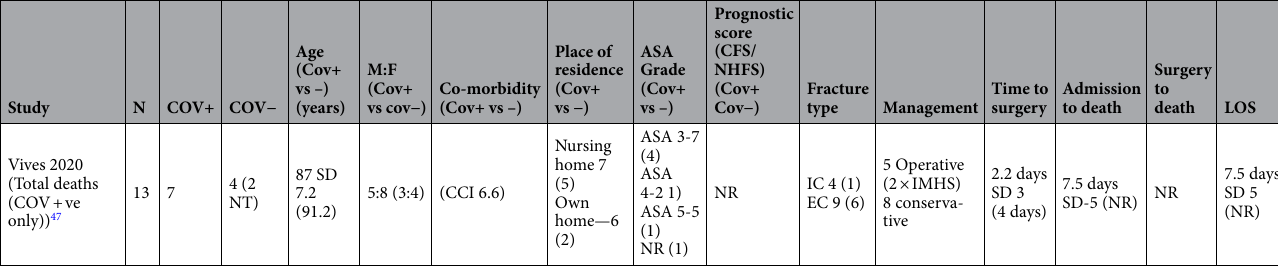
Table 3. Characteristics of deceased patients. N Number of patients, COV+ COVID-19 Positive patients, COV– non-COVID-19 patients, ASA American society of anaesthesiologists, LOS length of stay, NR Not reported, SD Standard deviation, CFS Clinical frailty score, NHFS Nottingham hip fracture score, IMHS Intramedullary Hip screw, HHA Hip hemiarthroplasty, DHS Dynamic hip screw, THA Total hip arthroplasty, CMN Cephalomedullary nail, EC Extracapsular, IC